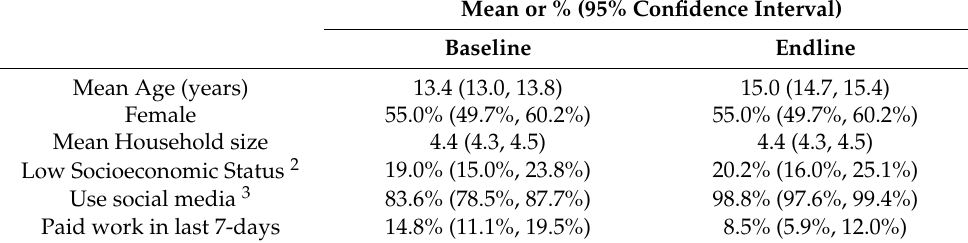
Table 1. Selected demographic characteristics 1